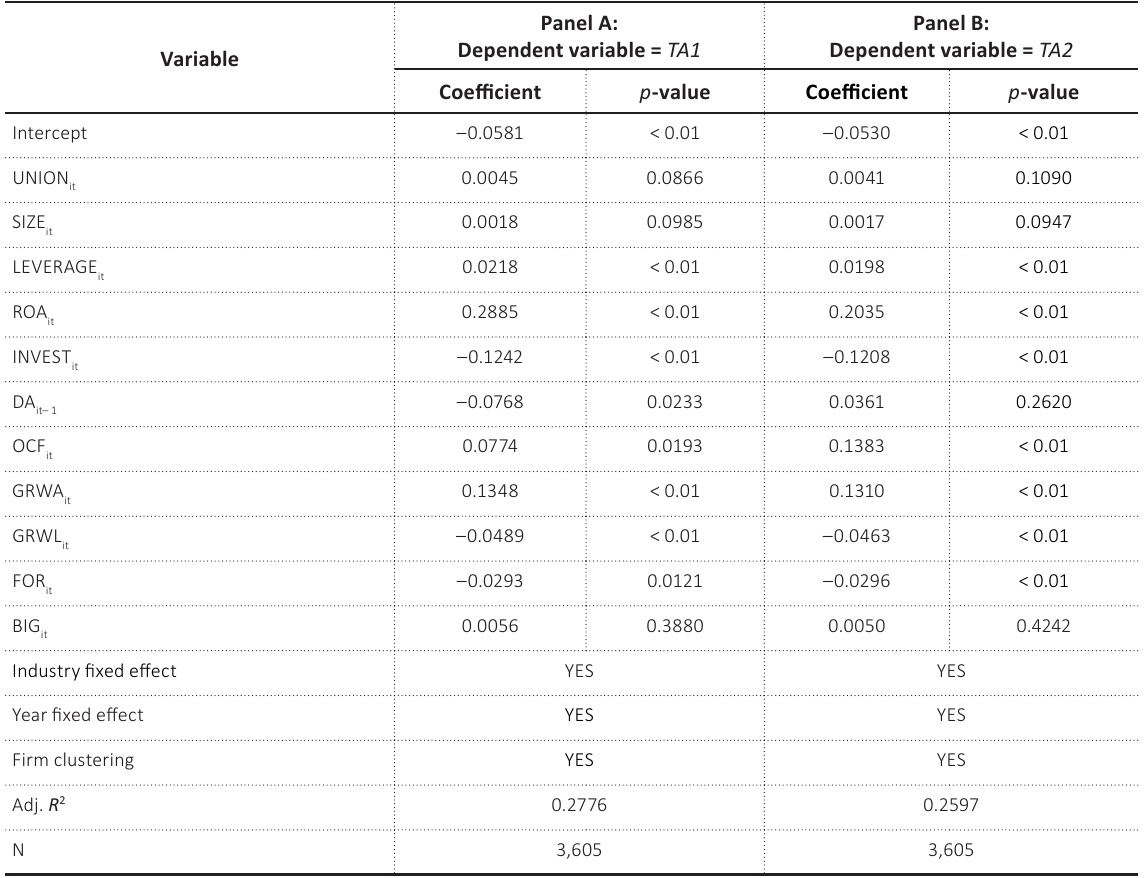
Table 2. Unionization and tax avoidance